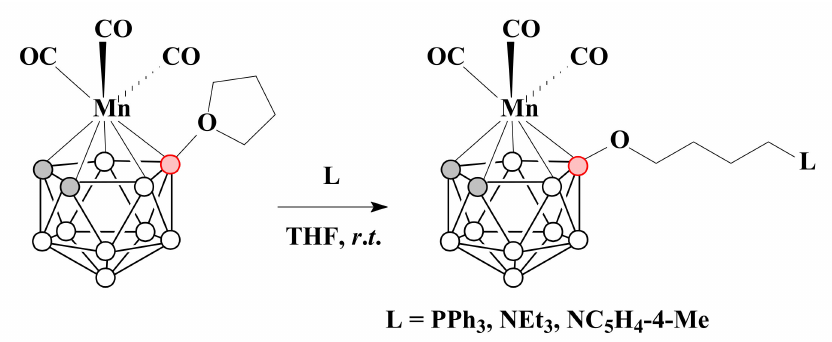
Scheme 24. The reaction of [3,3,3-(CO) 3 -3-Mn(8-(CH 2 ) 4 O-1,2-C 2 B 9 H 10 )] with PPh 3 , NEt 3 and 4-